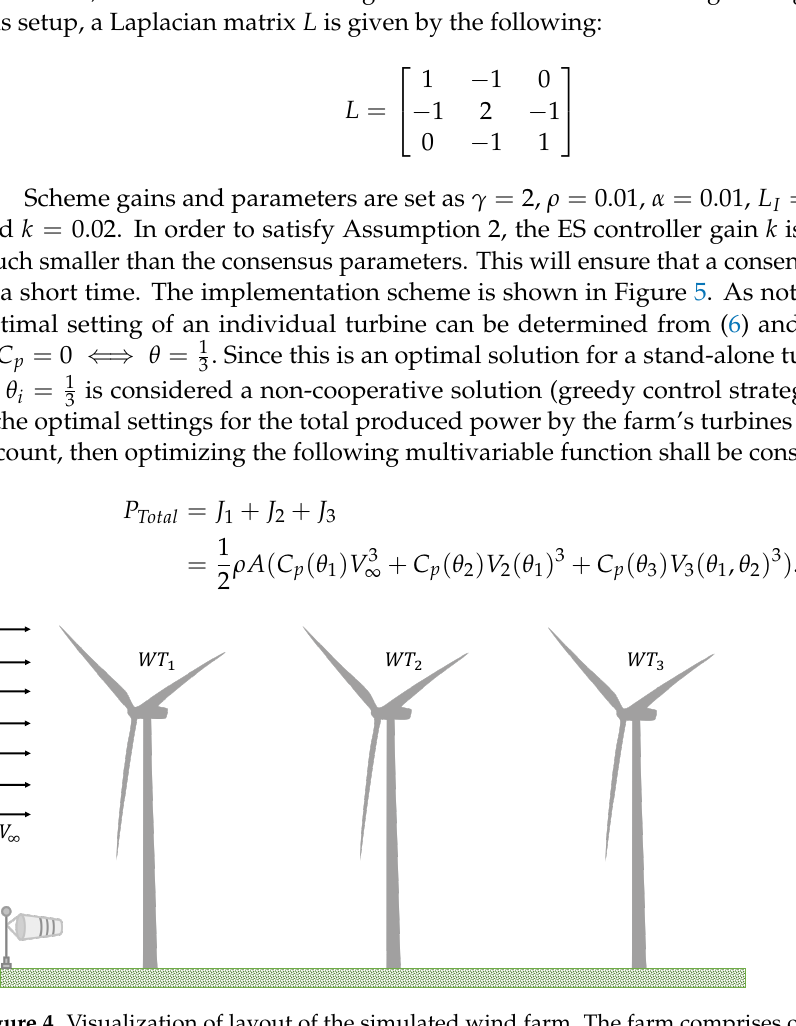
Figure 4. Visualization of layout of the simulated wind farm. The farm comprises of three turbines connected in